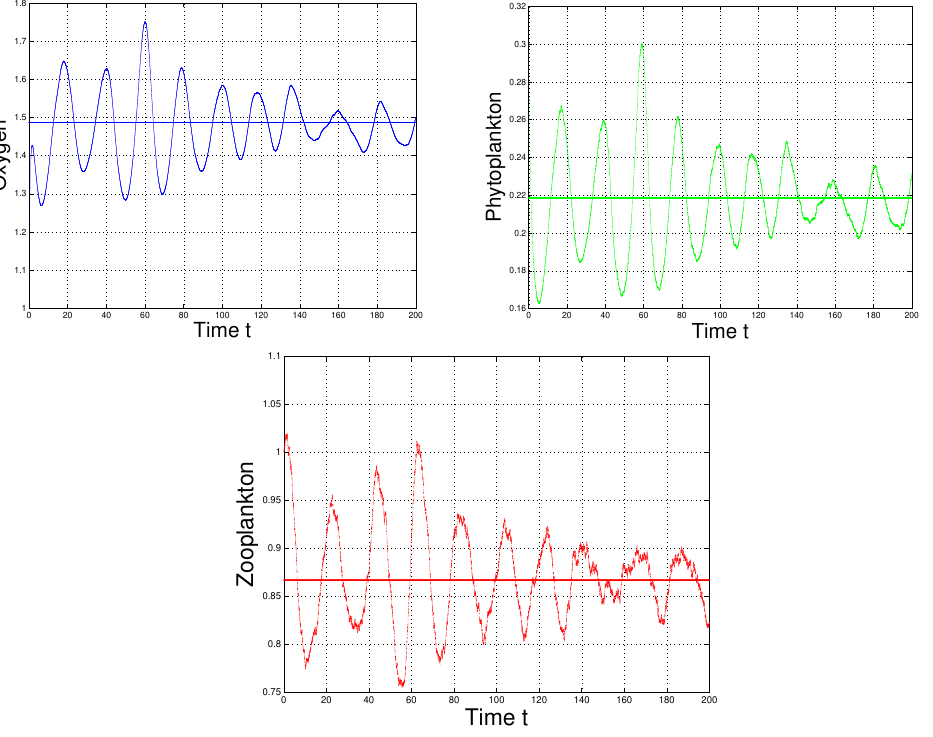
Figure 19. Stochastic trajectories of system (12) when A = 10 and the remaining parameters are same as in set (13). Initial conditions are c ( 0 ) = 1, p ( 0 ) = 0.3 and z ( 0 ) =